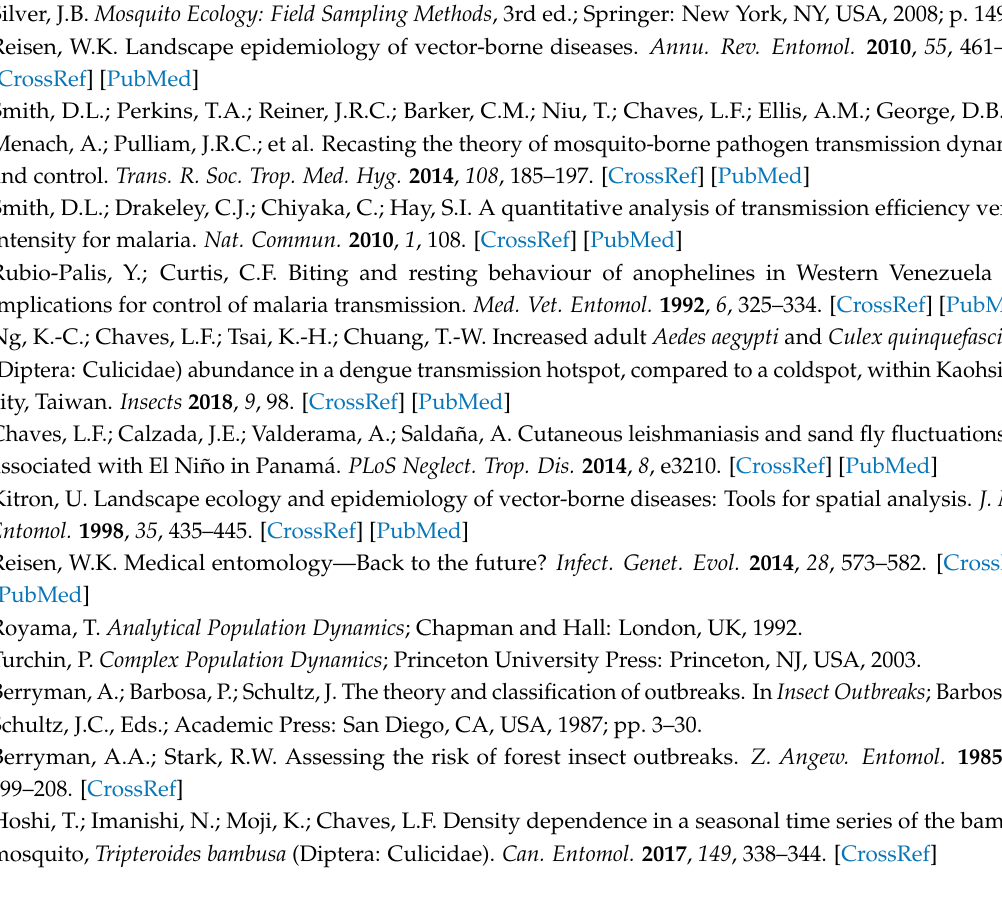
Table S1: Codes of Landsat 8 and Aster images employed to estimate NDVI at the sampling locations, Table S2: Abbreviations for the variables considered in the models; Table S3: Model selection for the best model explaining the persistence of Tripteroides bambusa adults at Mt Konpira, Nagasaki, Japan. The best model is bolded; Table S4: Model selection for the best model explaining the persistence of Tripteroides bambusa pupae at Mt Konpira, Nagasaki, Japan. The best model is bolded; Table S5: Model selection for the best model explaining the persistence of Tripteroides bambusa fourth instar larvae at Mt Konpira, Nagasaki, Japan. The best model is bolded; Table S6: Model selection for the best model explaining the persistence of Tripteroides bambusa small larvae at Mt Konpira, Nagasaki, Japan. The best model is bolded; Table S7: Model selection for the best model explaining Tripteroides bambusa adult abundance at Mt Konpira, Nagasaki, Japan. The best model is bolded; Table S8: Model selection for the best model explaining Tripteroides bambusa pupae abundance at Mt Konpira, Nagasaki, Japan. The best model is bolded; Table S9: Model selection for the best model explaining Tripteroides bambusa fourth instar larvae abundance at Mt Konpira, Nagasaki, Japan. The best model is